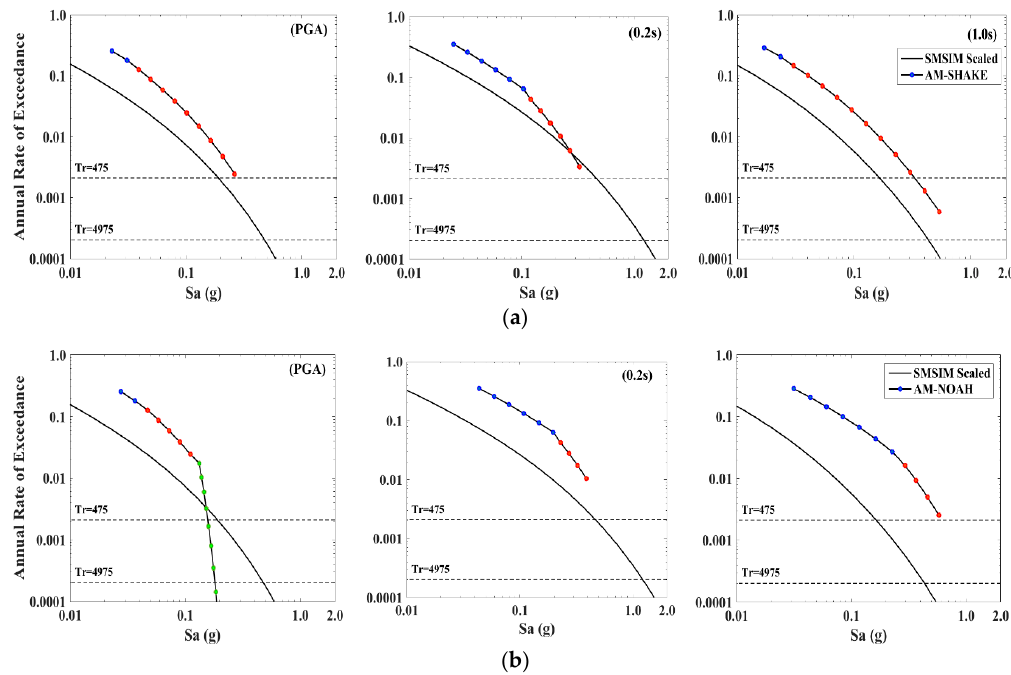
Figure 16. Hazard curves on soil estimated with the analytical approximation method (AM), for three different spectral periods (PGA, 0.2 s and 1.0 s). ( a ) Hazard curve on rock and soil derived from SHAKE91 accelerograms. ( b ) hazard curve on soil derived from NOAH accelerograms. The blue, red and green points correspond to the different regression sections used to modify the original hazard curve (see Figure 15a). Hazard curves on hard rock (black).